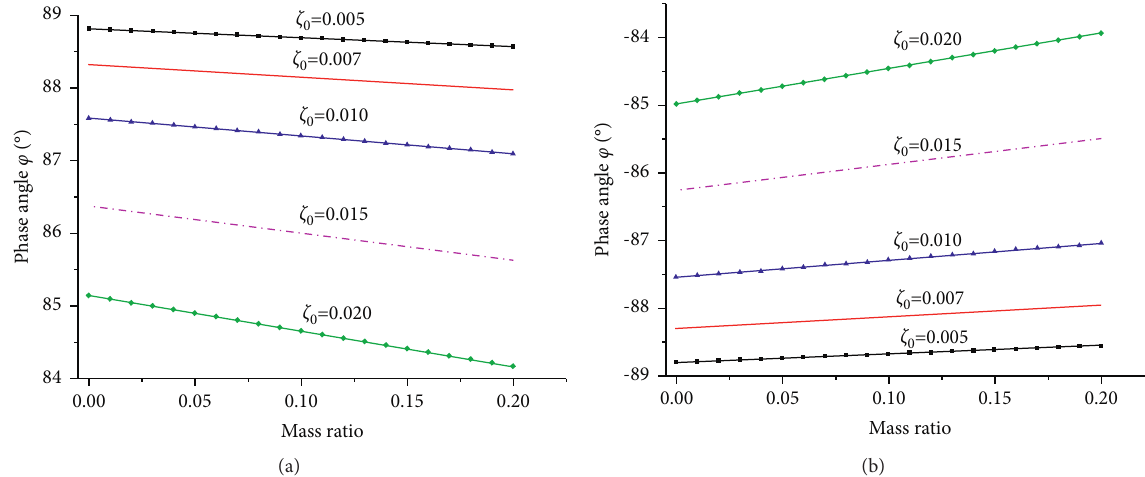
Figure 8: The relationship between phase angle and mass ratio of pedestrian and bridge motions under different damping ratios. (a) Positive phase angle. (b) Negative phase angle.